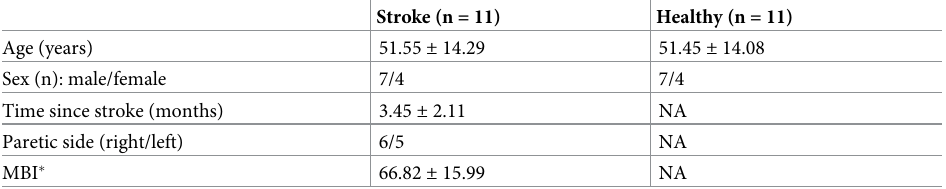
Table 1. Subjects’ characteristics.